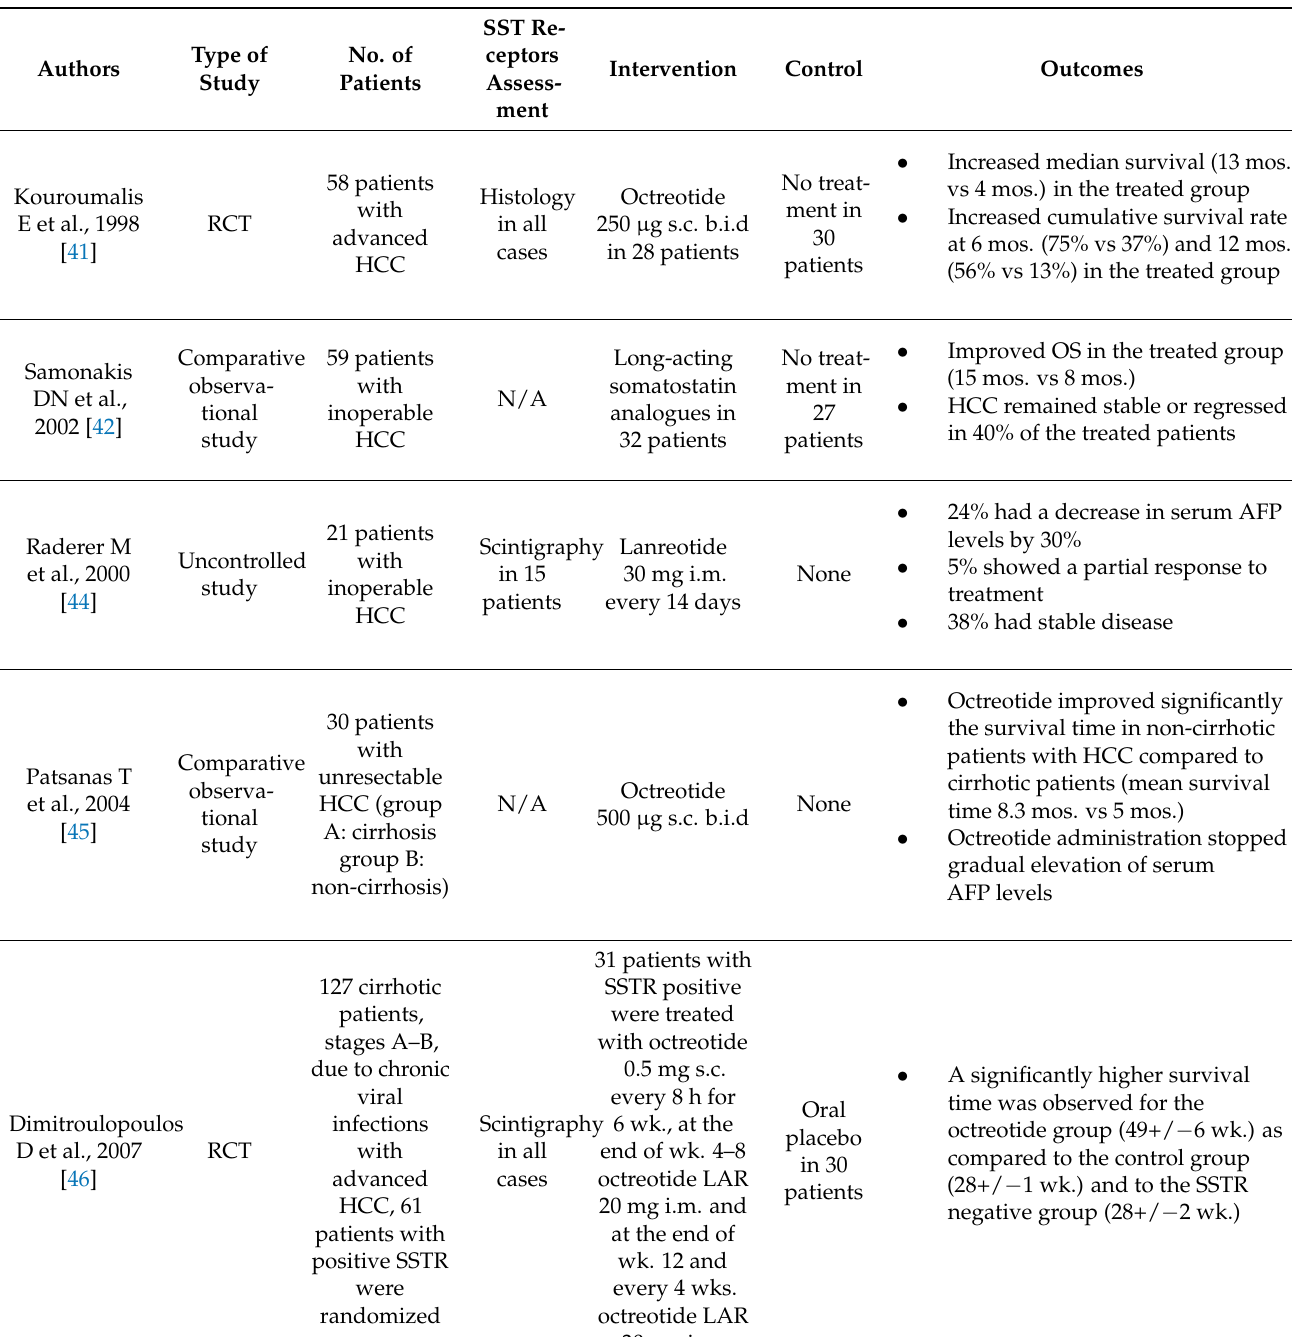
Table 1. Summary of the positive studies about the role of somatostatin analogues in the treatment of advanced